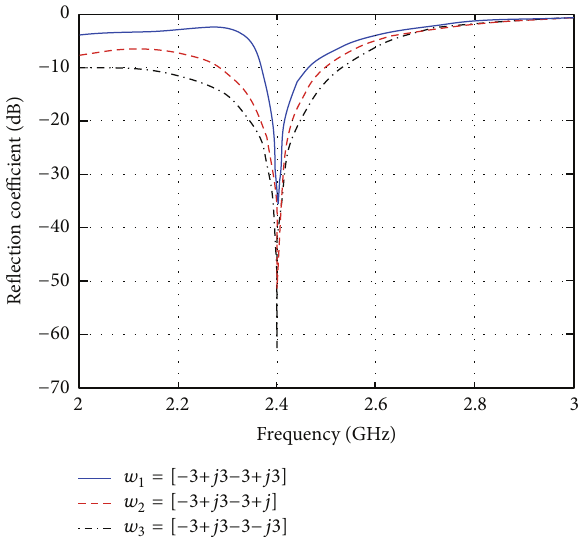
Figure 13: Simulated indicative return loss of the first 16 load